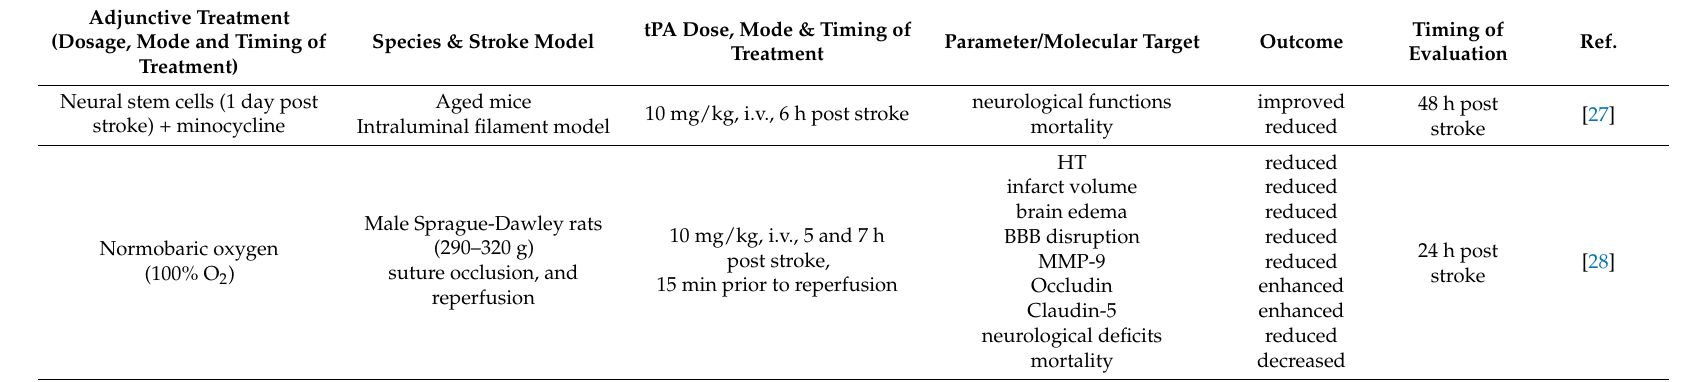
Table 2. Non-drug adjunctive treatments to extend therapeutic window for ischemic stroke